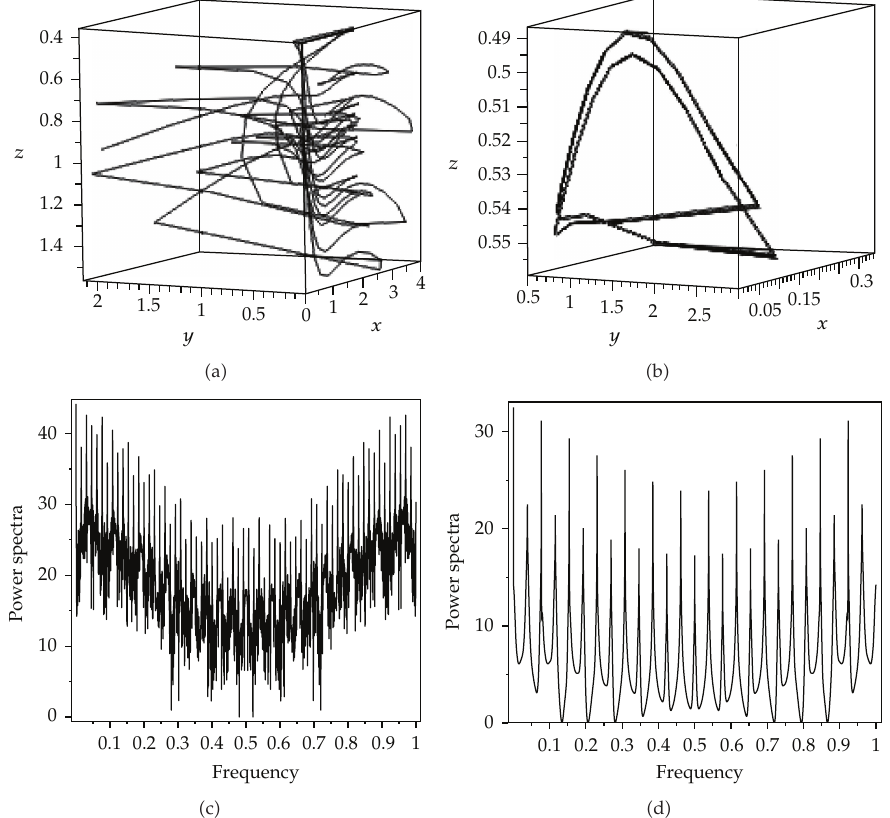
Figure 7: Strange attractors and power spectra: (cid:5) a (cid:6) strange attractor when p (cid:7) 2 . 2, (cid:5) b (cid:6) strange attractor when p (cid:7) 3 . 039, (cid:5) c (cid:6) power spectrum of attractor (cid:5) a (cid:6) , (cid:5) d (cid:6) power spectrum of attractor (cid:5) b (cid:6)